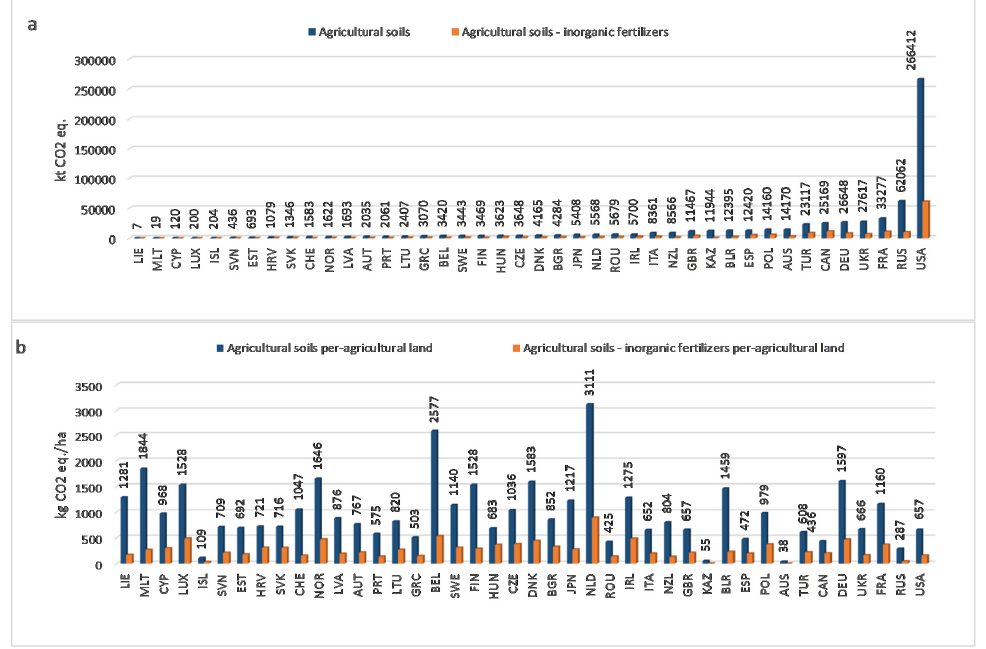
Figure 4. The soil nitrous oxide emissions ( a ), and the nitrous oxide emissions per agricultural land ( b ) from soils in each Annex I country for 2017. Numbers indicate the amount of nitrous oxide emissions in kt CO 2 equivalent in each country ( a ) and the amount of nitrous oxide emission per agricultural land in kg CO 2 equivalent in each country ( b ).